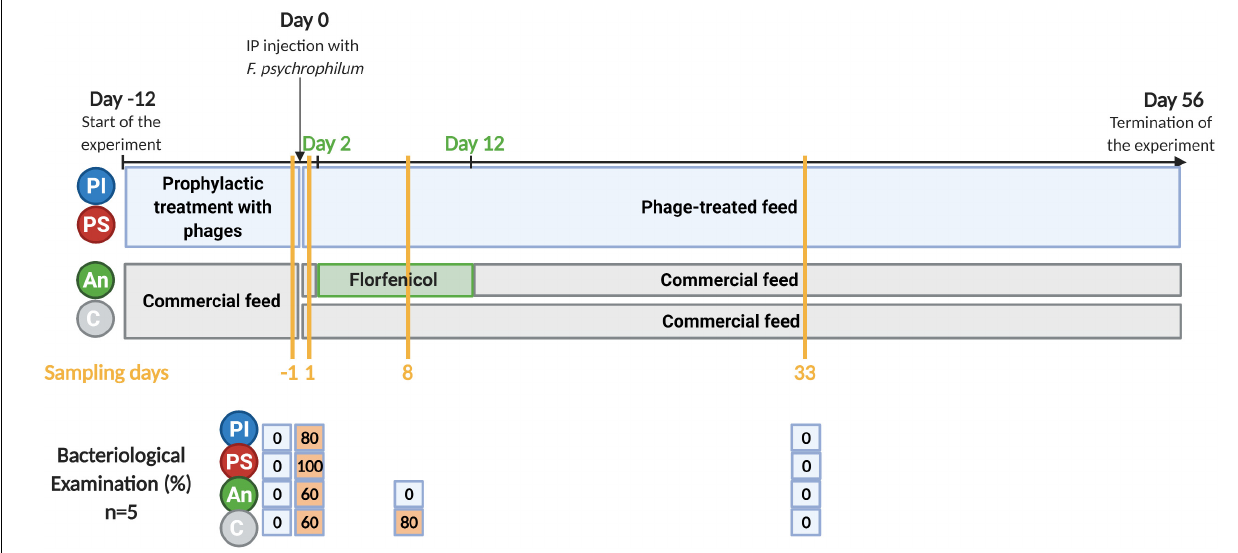
FIGURE 1 | Timeline of the experiment. C, control feed group; An, antibiotic feed group; PI, phage-immobilized feed group; PS, phage-sprayed feed group. The results of the bacteriological examination performed on sampled fish are presented (% of fish positive to re-isolation of F. psychrophilum ). Created with BioRender.com (the figure was exported under a paid